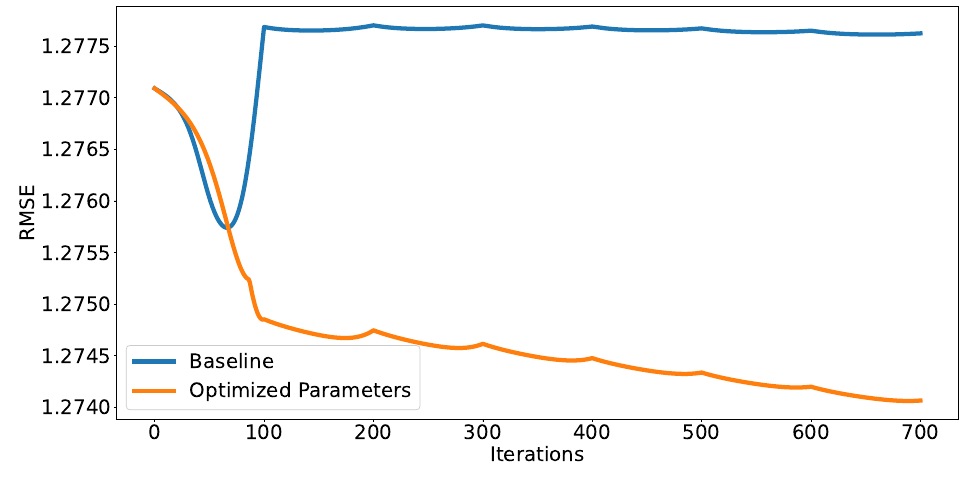
Figure 1. A comparison of the convergence of the baseline MF algorithm on the CoMoDa dataset using the original parameters from [17] (blue) and GE optimized parameters